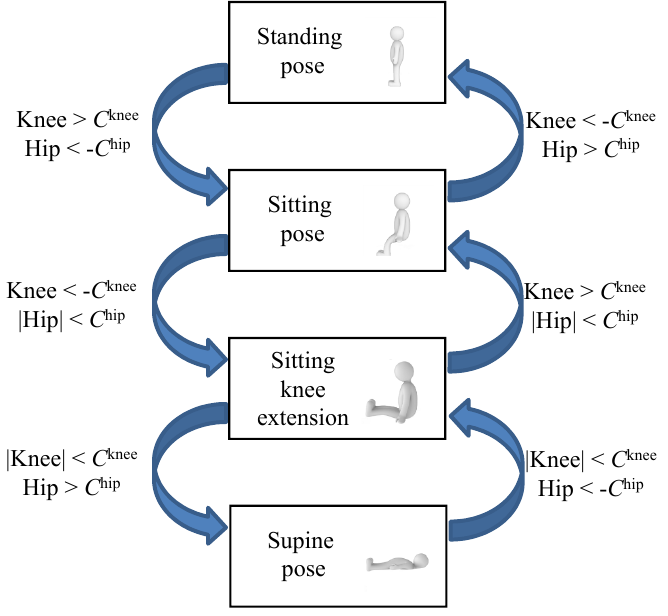
Figure 8. Flow chart for posture